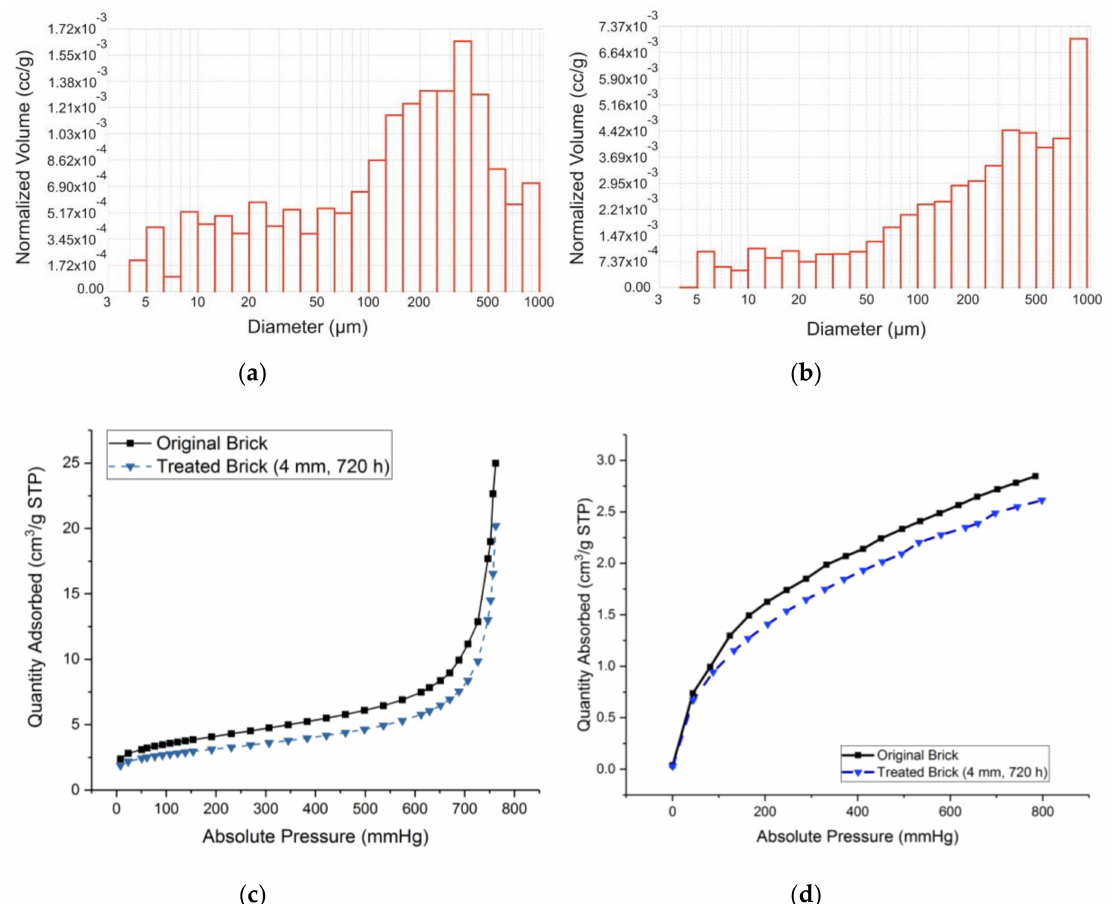
Figure 9. ( a , b ) Histograms of Hg porosity, ( c ) N 2 adsorption, and ( d ) CO 2 adsorption isotherms for original brick and treated brick